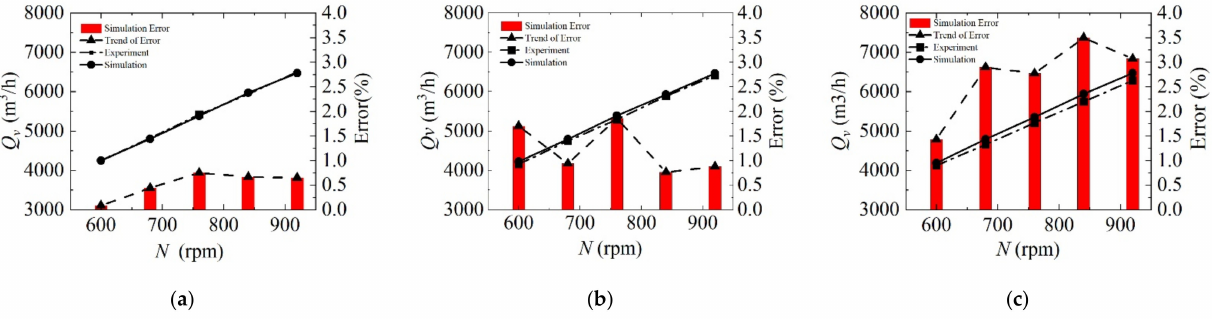
Figure 15. Volume flow rate in simulations: ( a ) Case-Basic, ( b ) Case-10, and ( c )